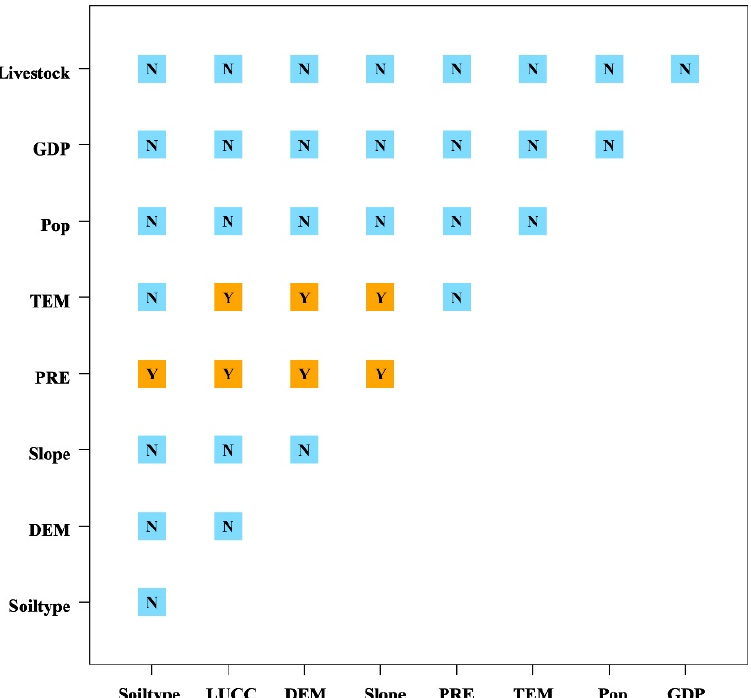
Figure 12. Ecological detector results for each factor of the NDVI in Inner Mongolia from 2000 to 2019. Note: positions marked with Y in the figure indicate significant differences in the influence of each factor on the spatial distribution of vegetation NDVI, with different influence mechanisms; positions marked with N indicate the lack of significant differences in the influence mechanisms of the two factors on the spatial distribution of NDVI.